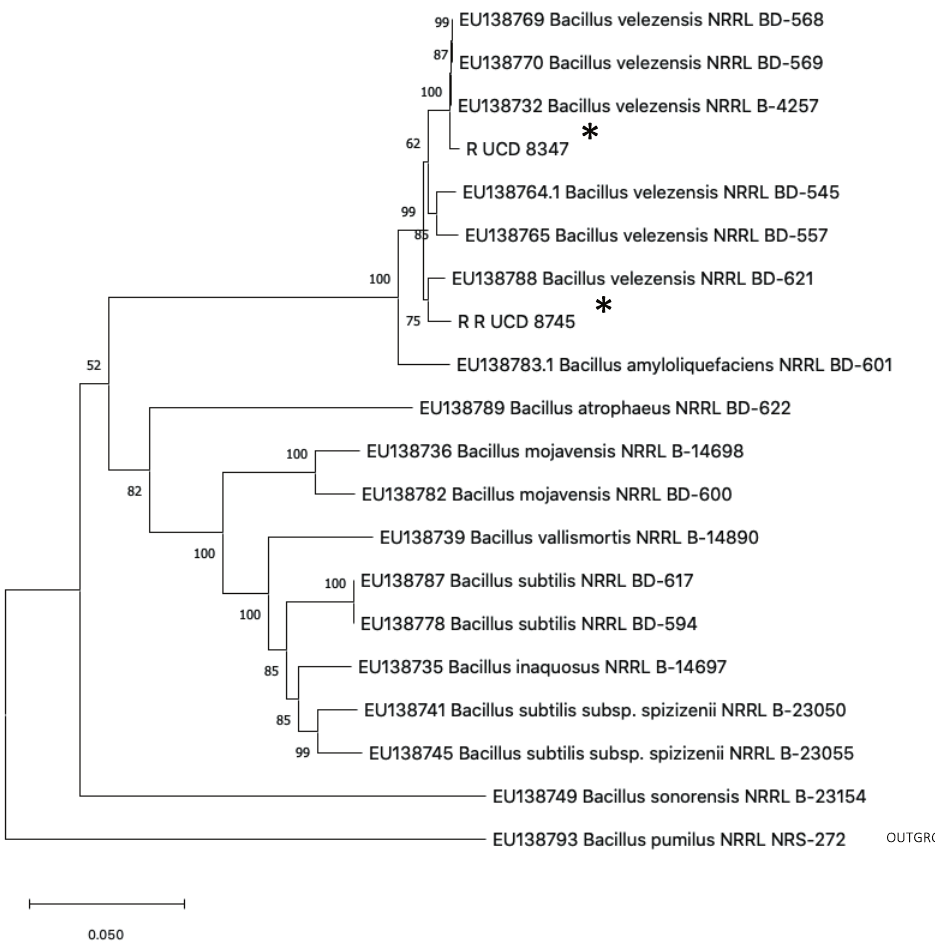
Figure 7. Maximum parsimony phylogenetic tree for isolates of UCD 8347 and UCD 8745 based on a multigene data set of purine biosyn- thesis ( purH ) and RNA polymerase subunit B ( rpoB ). Bootstrap support for the maximum-likelihood analysis is given at each node (1000 replicates). * indicates isolates evaluated in this study. Bacillus pumilus EU138793 was used as an